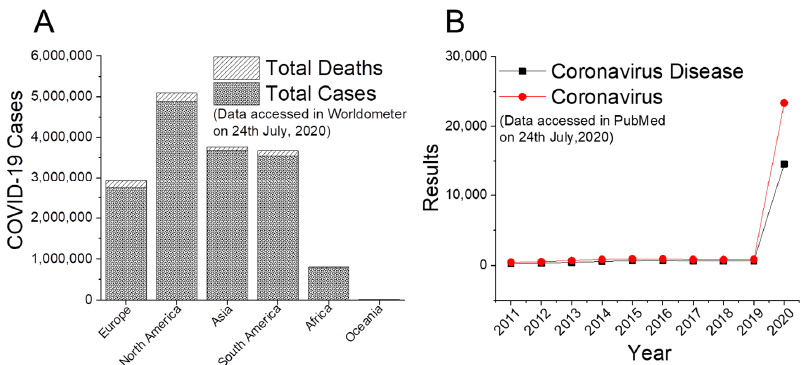
Figure 1. ( A ) Distribution of COVID-19 cases over various continents according to Worldometer (data accessed on 24th July, 2020). ( B ) Year-wise results for research on “Coronavirus” and “Coronavirus Disease” keyword for last 10 years (2020–2011) according to PubMed (data accessed on 24th July, 2020).